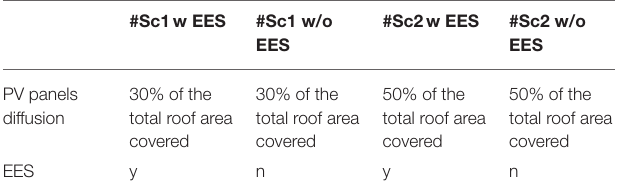
TABLE 2 | Overview of the modeled electricity distribution scenarios.